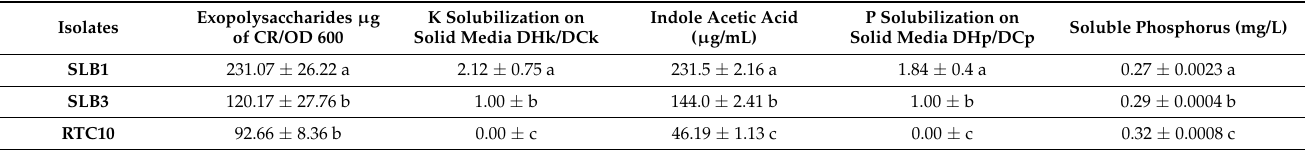
Table 1. Phosphorus and potassium solubilization in liquid and solid media and other PGR parame- ters: exopolysaccharide production and indole acetic acid by bacterial strains.